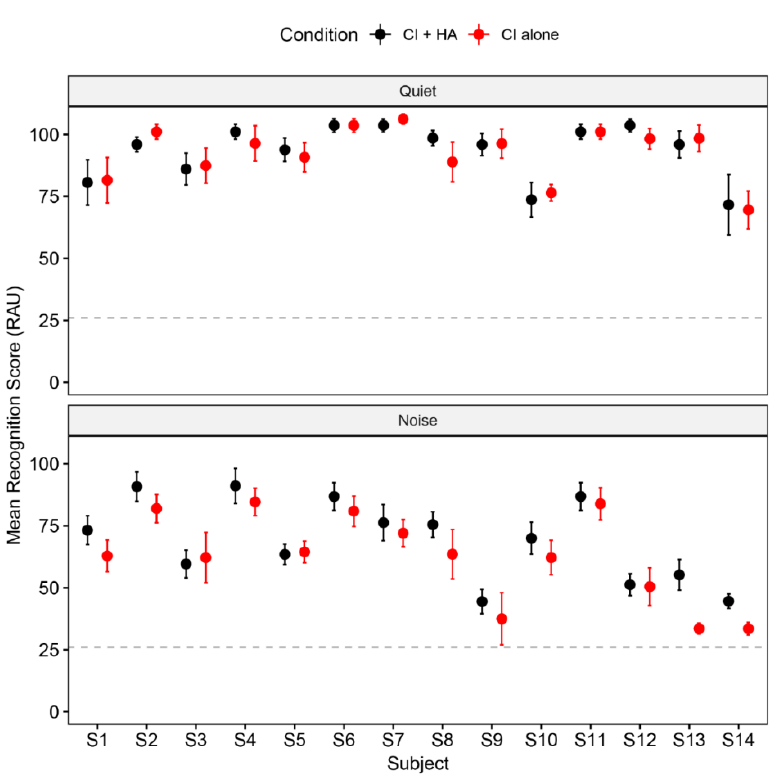
Figure 4. Mean RAU scores of natural tone recognition for each participant in quiet and noise. Dash lines indicate the chance level. Error bars represent the standard errors across four tone types.